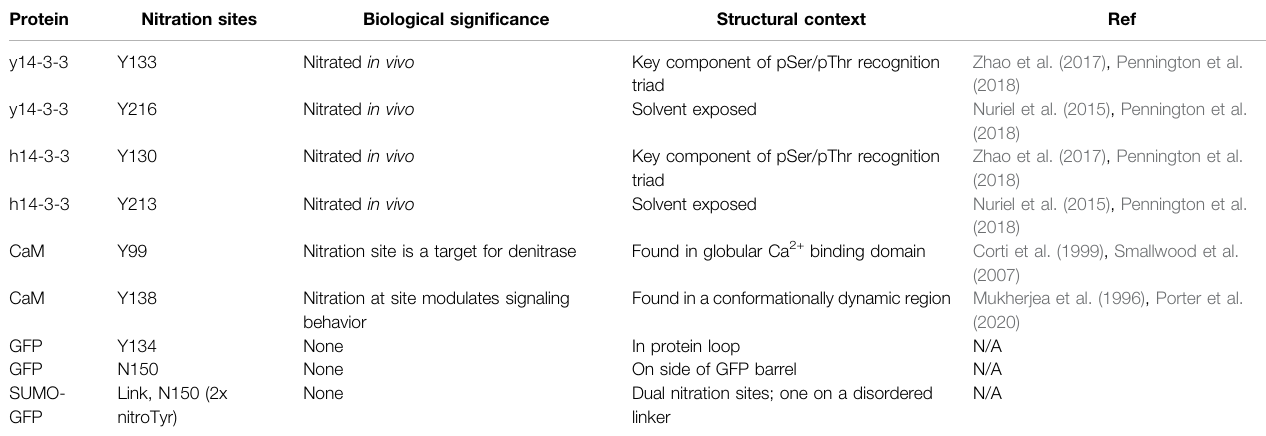
TABLE 1 | NitroTyr proteins produced for Nb